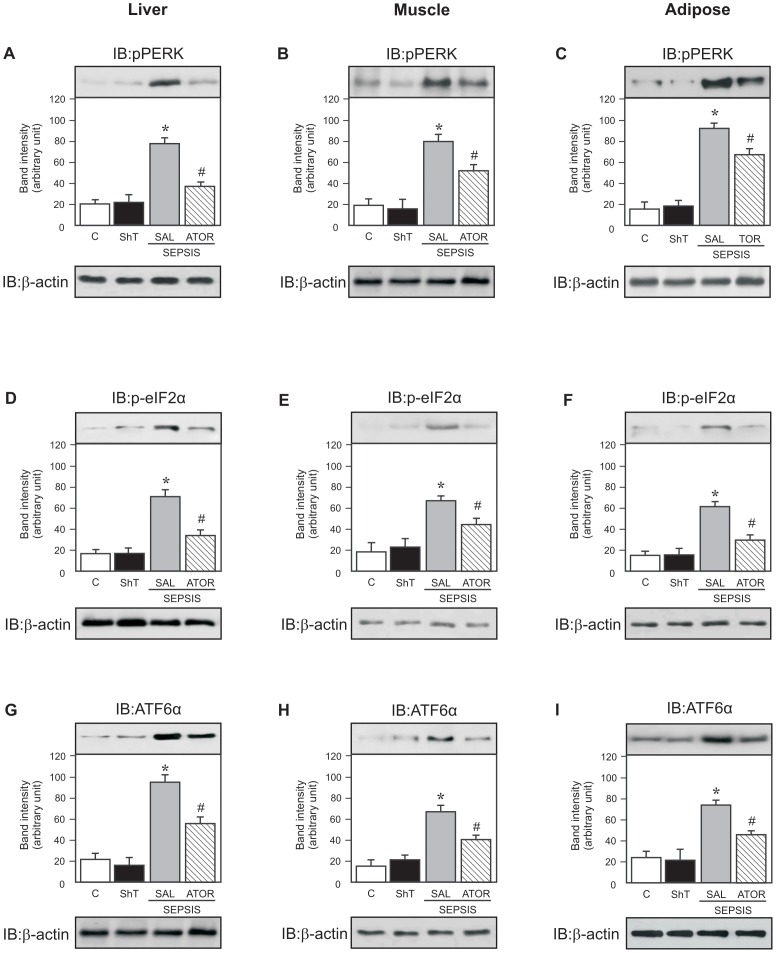
Representative blots show the PERK phosphorylation in liver (A), muscle (B) and adipose tissue (C) of sham and septic rats.eIF2α phosphorylation (D–F) and ATF6 (G–I) expression in liver, muscle and adipose tissue of sham and septic rats. In this case, blots were stripped and reprobed with actin (A–I, lower panels) to confirm equal loading of proteins. Data are presented as means ± S.E.M from 6–8 rats per group. *P<0.05 (Sepsis/Sal vs. all others groups); #P<0.05 (Sepsis/Sal vs. Sepsis/Ator). IB, immunoblot; CLT: Sham/Saline; ShT: Sham/Atorvastatin; SAL: saline; ATOR: atorvastatin.